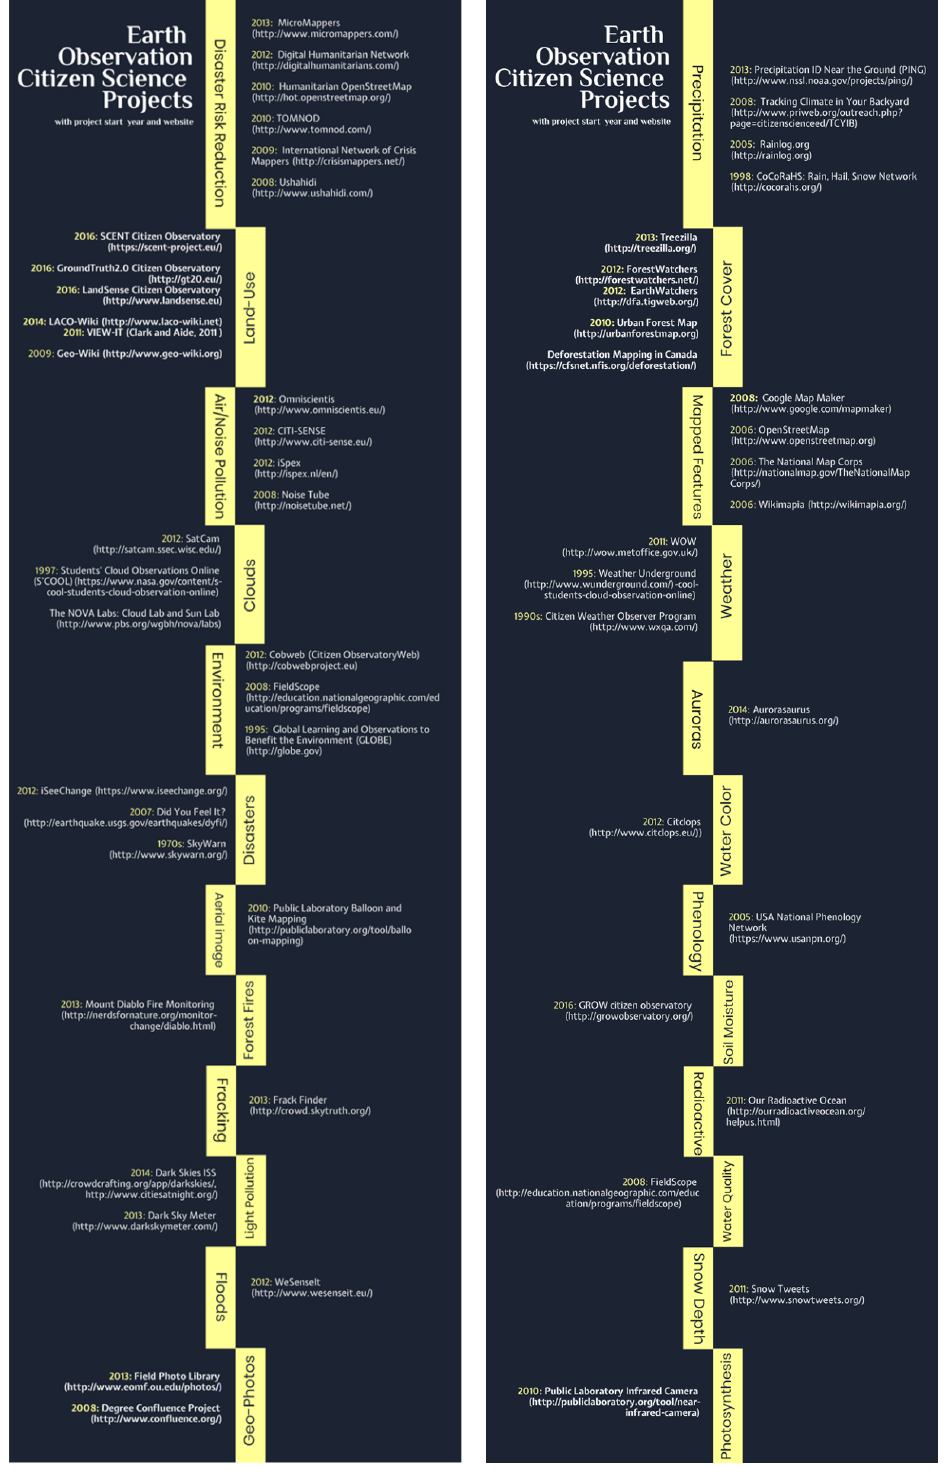
Figure 1. Examples of Citizen Science (CS) initiatives that are relevant to Earth Observation (EO), Adopted from Table 1 of Fritz et al. (2017) [36], (pp. 3–4).